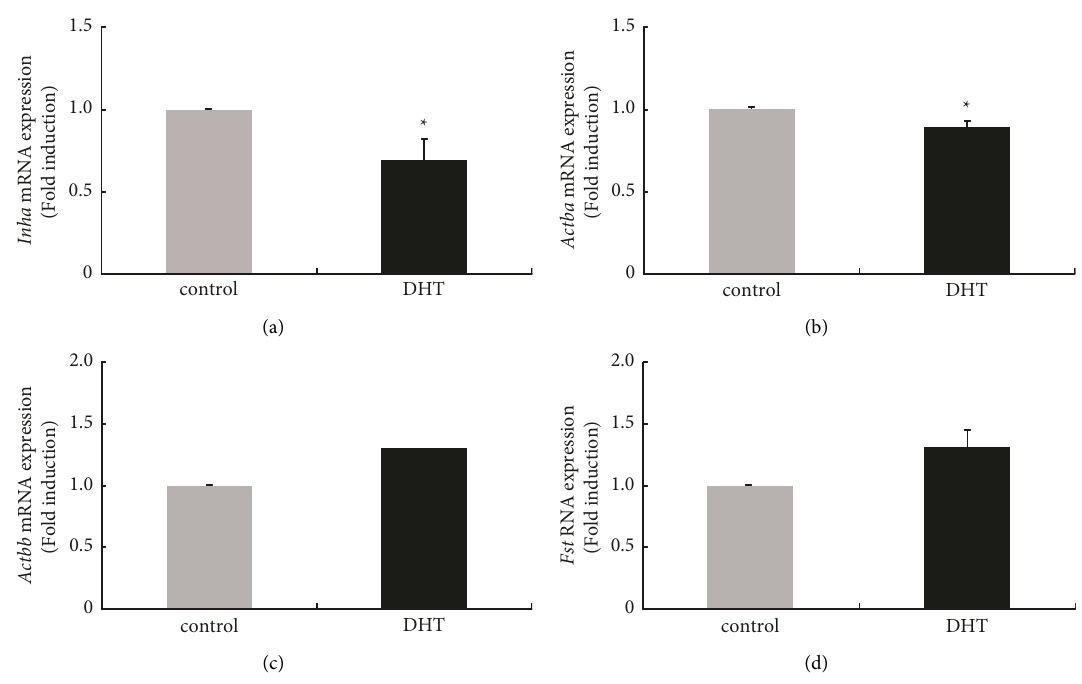
Figure 4: Effect of dihydrotestosterone (DHT) administration on the gene expression of inhibin/activin subunits and follistatin in the anterior pituitary. Six-week-old female rats were injected subcutaneously with DHT (5mg/kg/day) daily for 7 days. After the rats were euthanized, the anterior pituitary was removed from nontreated ( n � 4) and DHT-treated rats ( n � 4), and then mRNA was extracted from the anterior pituitary tissue and reverse transcribed. Inha (a), Actba (b), Actbb (c), and Fst (d) mRNA levels were measured by quantitative RT-PCR. Samples from each experimental group were run in duplicate and normalized to the mRNA levels of Gapdh. The results are expressed as fold induction over the control and presented as the mean ± SEM. ∗ P < 0 . 05 versus the